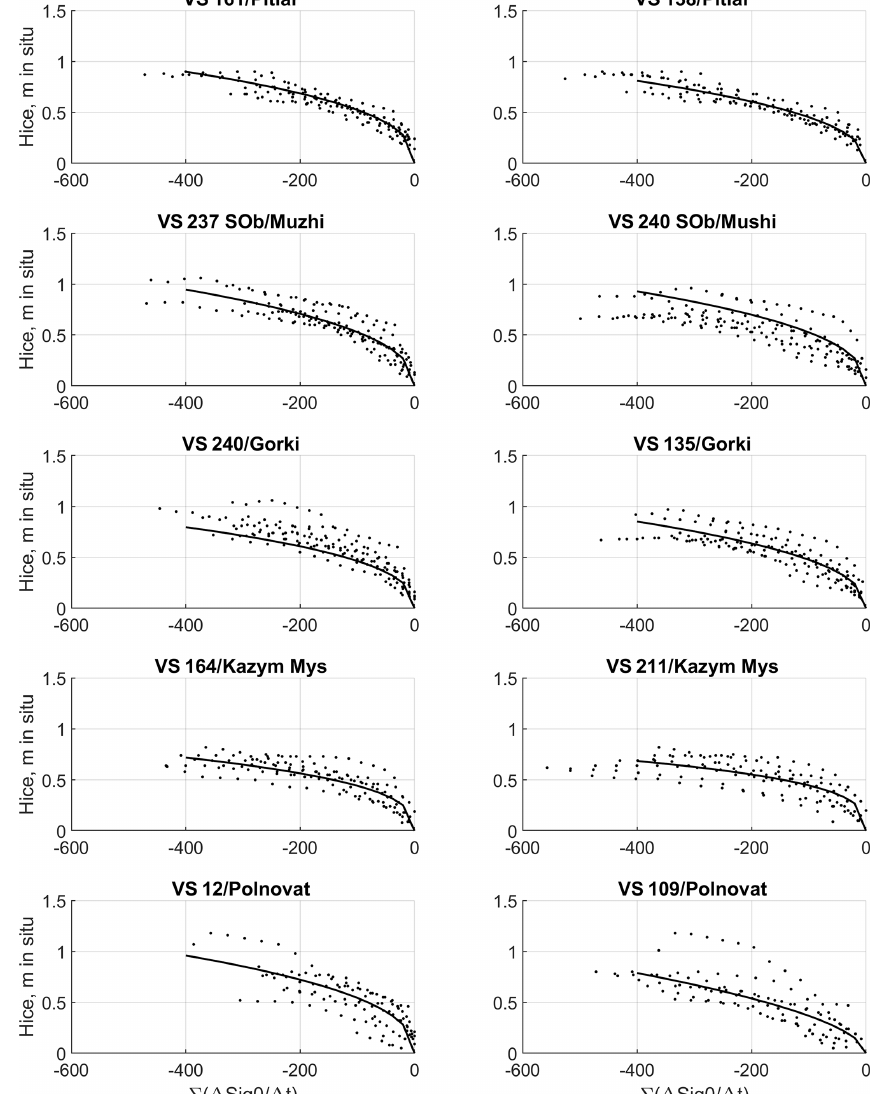
Figure 5. Relationship between (cid:54)((cid:49) Sig0 /(cid:49)t) and in situ ice thickness at 10 virtual stations.